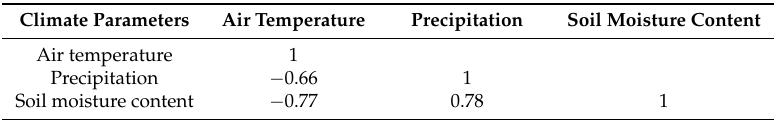
Table 3. Correlation ( r ) matrix among the air temperature, precipitation and soil moisture content over the sixteen stations during the growing season of 2000–2013. Correlation was between two climatic parameters with a significance level of p < 0.001.